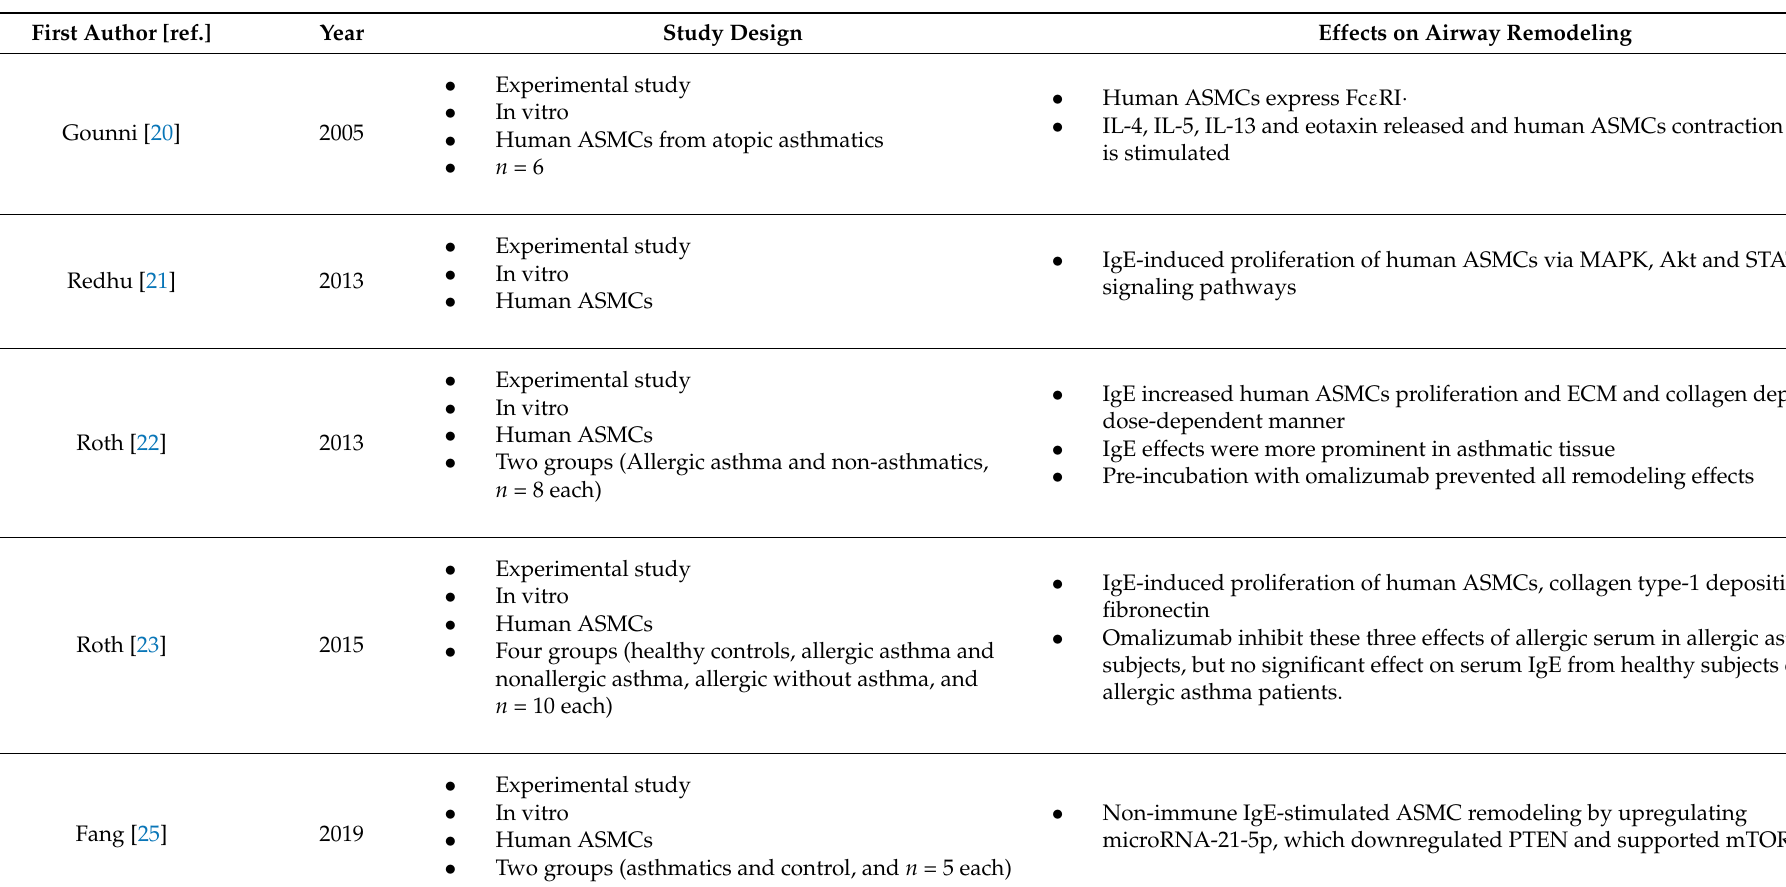
Table 1. Summary of effects of immunoglobulin E (IgE) on airway